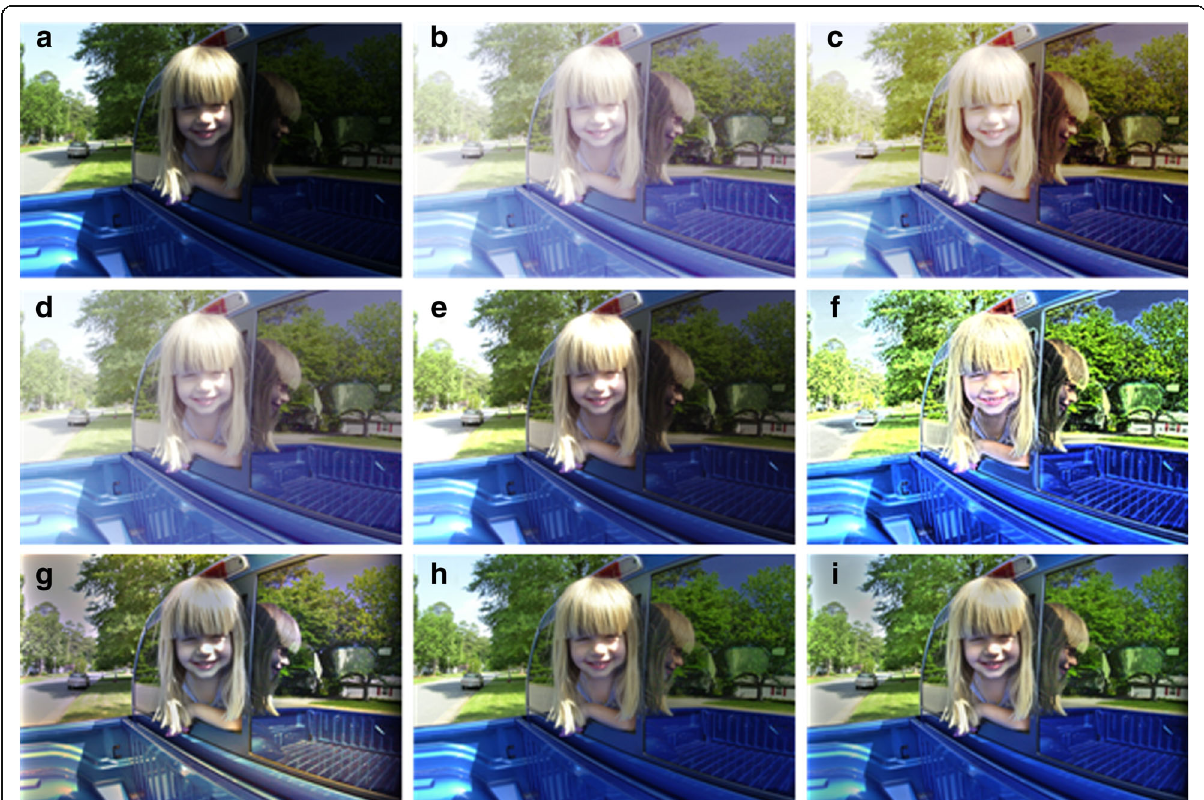
Fig. 5 Experimental results on girl. a Original image; b MSR; c LHE; d AL; e ALTM; f GUM; g SARV; h NPE; i